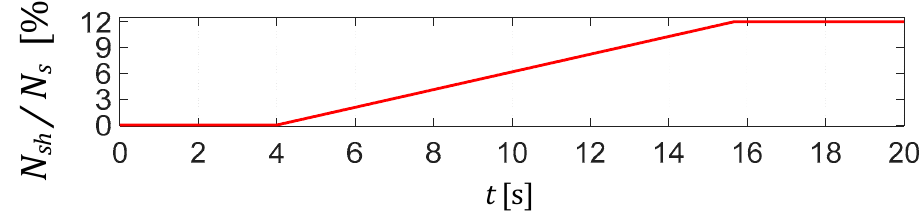
Figure 4. Trajectory of the fault fraction during tests.